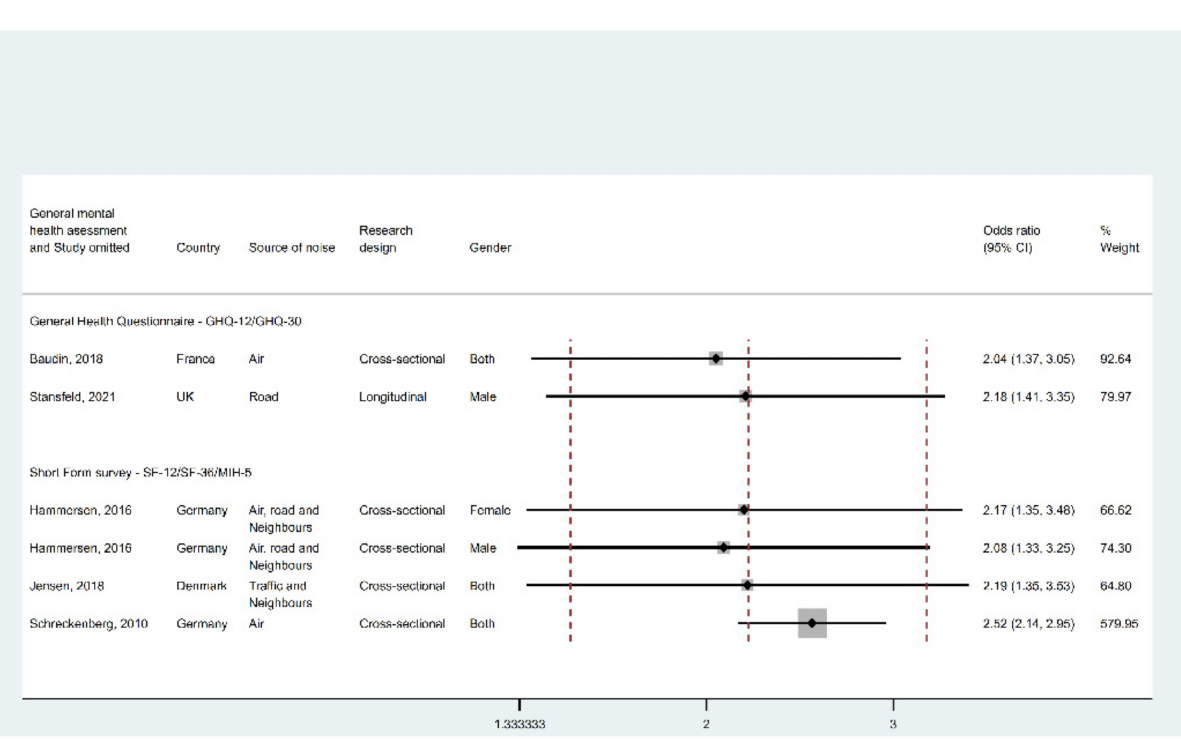
Figure A5. Leave-one-out analysis for identifying outliers in general mental health studies. Note: weights are from random-effects model.